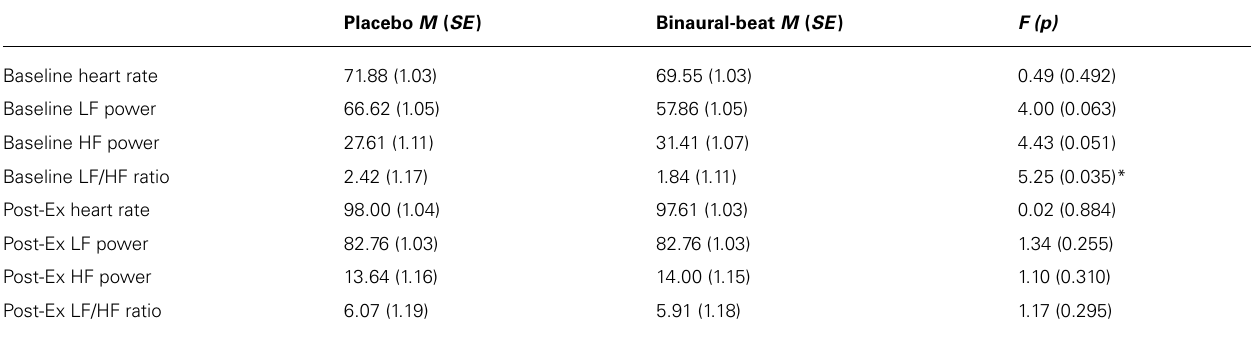
Table 2 | Baseline and post-exercise measures of heart rate